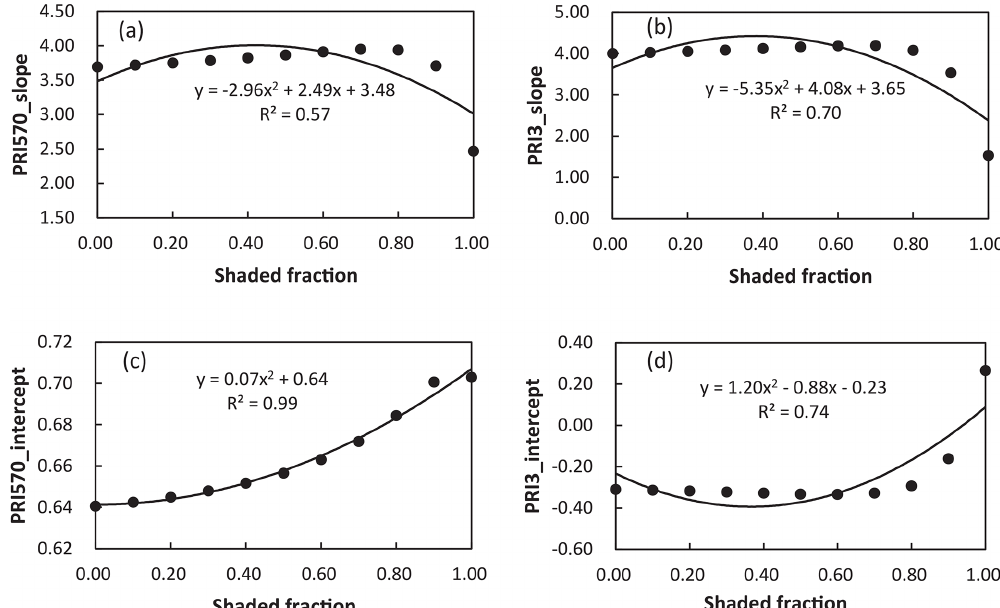
Figure 5. Relationships between shaded-leaf fractions and the slope of the linear regression models of RWC and PRI570 ( a ) and PRI3 ( b ); and relationships between shaded-leaf fractions and the intercept of the linear regression models of RWC and PRI570 ( c ) and PRI3 ( d ).